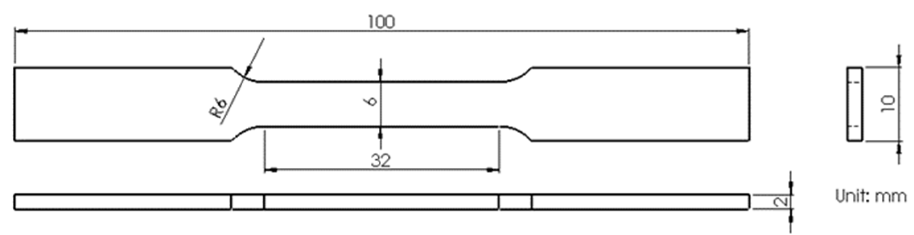
Figure 2. Tensile specimen configuration.